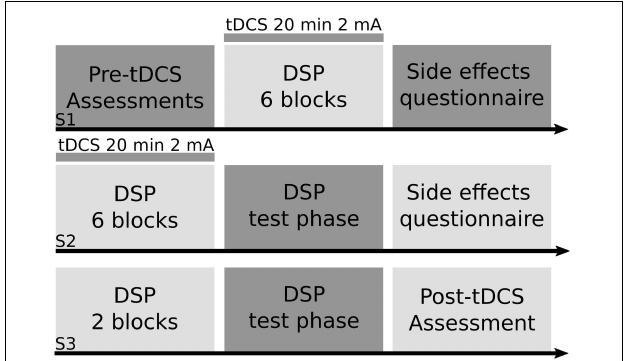
FIGURE 1 | Study design. Using a between-subjects design, right-handed older adult participants practiced a motor sequence task paired with transcranial direct current stimulation (tDCS). Participants were randomly assigned into one of four anodal tDCS groups (right prefrontal cortex, left prefrontal cortex, left primary motor cortex, supplementary motor complex) or sham for the entirety of the study. In session one (S1) older adult participants completed a battery of cognitive and motor tasks (pre-tDCS assessments), followed by six blocks of the discrete sequence production (DSP) task paired with either real or sham tDCS for a maximum of 20 min at 2 mA, followed by a tDCS side effects questionnaire. In session two (S2), participants practiced another six blocks of the DSP task paired with either real or sham tDCS, followed by a test portion of the DSP task, where participant’s explicit knowledge of the sequence was tested, followed by a tDCS side effects questionnaire. In session three (S3), participants completed two blocks of the DSP task without tDCS, then completed the test portion of the DSP task, followed by the same battery of cognitive and motor tasks (post-tDCS assessment) that participants completed at the start of